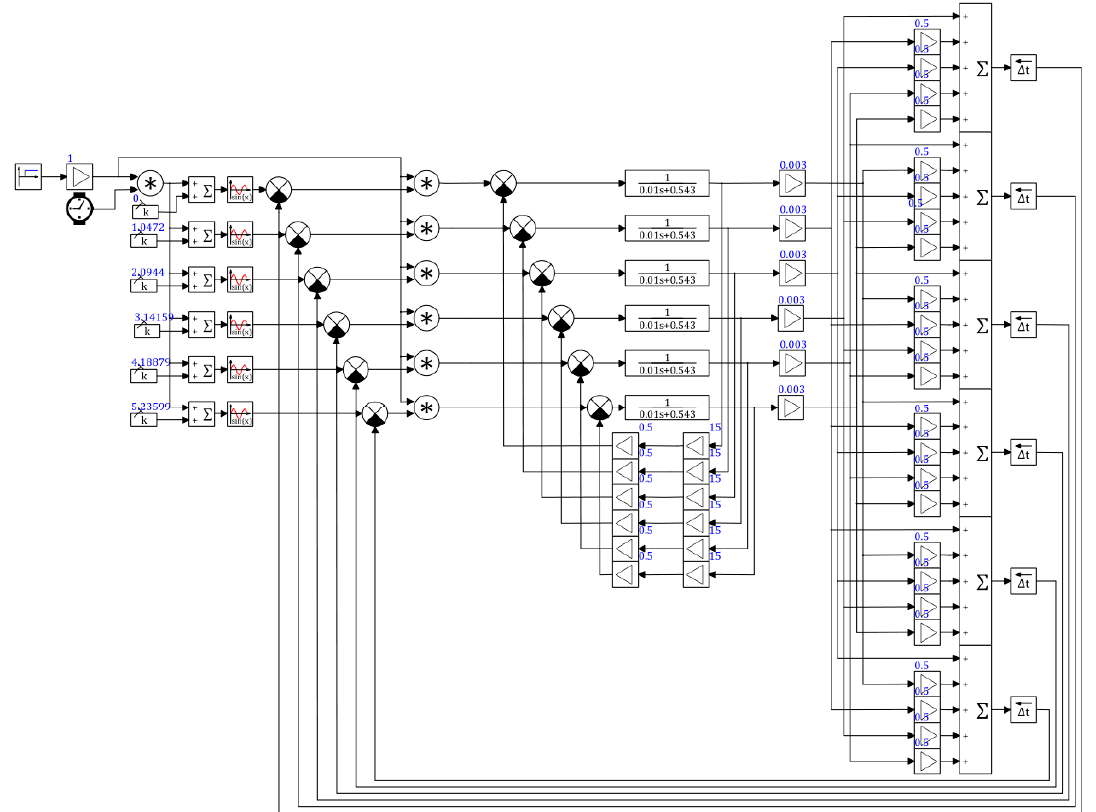
Figure 23. Mathematical model of a three-phase generator.